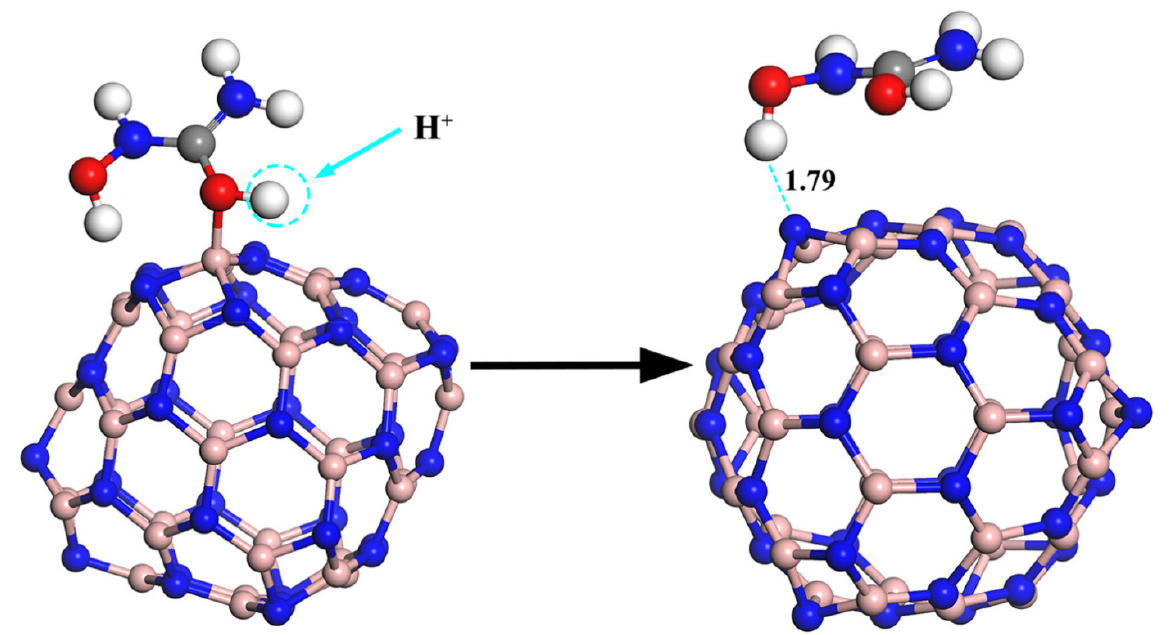
Figure 5. The optimized configuration of the structure of protonated hydroxyurea on the B36N36 surface demonstrates drug release. Reproduced with permission from ref. [67]; Copyright 2020, Elsevier Science Ltd.